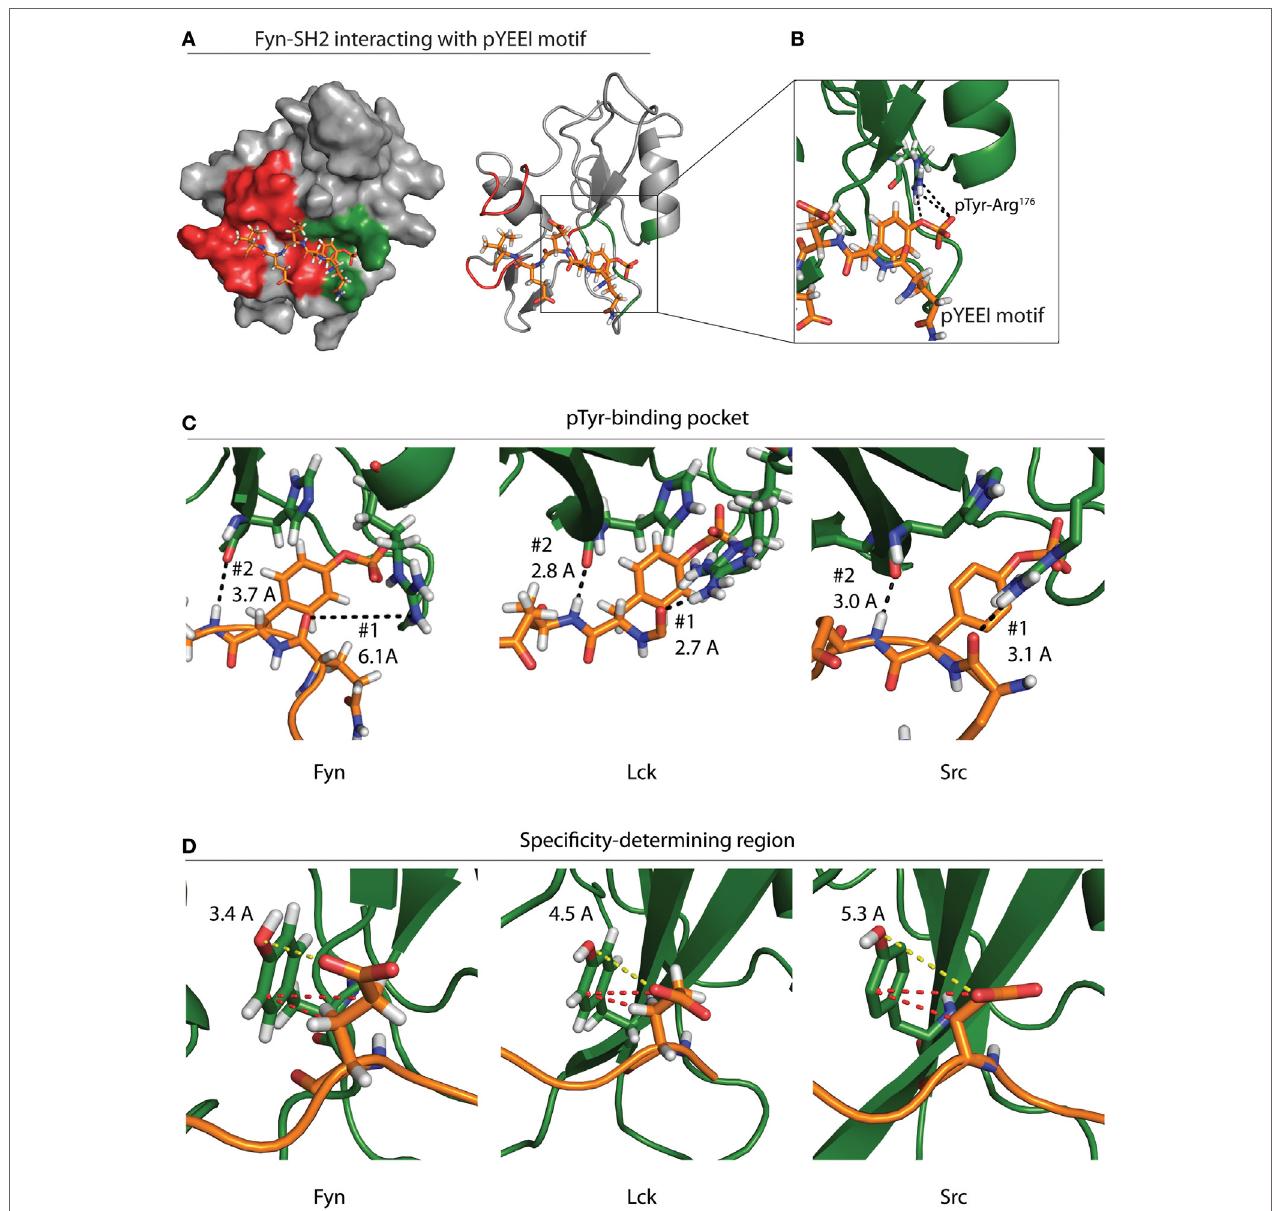
FiGURe 4 | Specificity of the Fyn–ADAP interaction . (A) Surface and ribbon models show the Fyn SH2 domain bound to a pYEEI peptide motif. Green shading on the surface model represents the phosphotyrosine-binding pocket, while red shading represents the specificity-determining region. The ribbon model shows that the pYEEI peptide lies orthogonal to the β -sheet of the SH2 domain. This positions the phosphorylated tyrosine in a hydrophilic pocket in between the β -sheet and the α A helix. The linear conformation of the peptide allows residues C-terminal to the phosphotyrosine to interact with other regions of the SH2 domain, which increases specificity and affinity of the Fyn–substrate interaction. Both the surface and ribbon model are derived from PDB deposition 1AOT. (B) An exploded view of the primary binding pocket highlights the interaction between the phosphotyrosine and the conserved Arg β B5 of Fyn. Salt-bridge formation at this site contributes roughly 50% of the binding energy required for the SH2 peptide interaction. (C) Comparison of different SFKs bound to pYEEI motifs show varied interactions at the phosphotyrosine-binding pocket. Ribbon models of Fyn (left), Lck (center), and Src (right) highlight bond distances between Arg α A2 of the SH2 domain and a backbone carbonyl on the target peptide (#1). Bond distances show that Arg α A2 is capable of interacting with the backbone of the pYEEI motif in Src and Lck but not in Fyn. Ribbon models also show the distance between the backbone carbonyl of His β D4 of the SH2 domain and backbone amide of the pYEEI motif (#2). These bond distances suggest that the structure of the Fyn SH2 domain places pYEEI motifs in a more extended conformation than that seen in Src or Lck. (D) Measurements obtained from PDB depositions show the distance between Tyr β D5 of the SH2 domain and the glutamate residue in the + 1 position from the phosphotyrosine. The shorter distance in Fyn (left) means that hydrogen bonding is possible between Tyr β D5 and the + 1 glutamate residue of the pYEEI motif, while bonding is based primarily on hydrophobic interactions (red dashes) in Lck (center) and Src (right). This may provide an explanation for the ability of Fyn to act as the sole kinase responsible for recruitment of ADAP, as less hydrophobic interactions would be possible between the SH2 domain and YDGI motif of ADAP. Measurements are based on PDB depositions 1AOT for Fyn, 1LKK for Lck, and 1SPS for